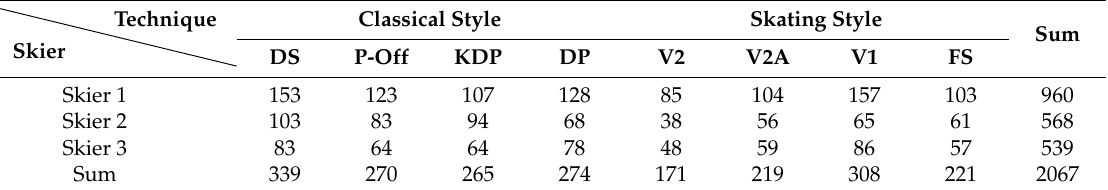
Table 4. Number of cycles of the classical (DS, P-Off, KDP, DP) and skating (V2, V2A, V1, FS) techniques performed by each skier in the training